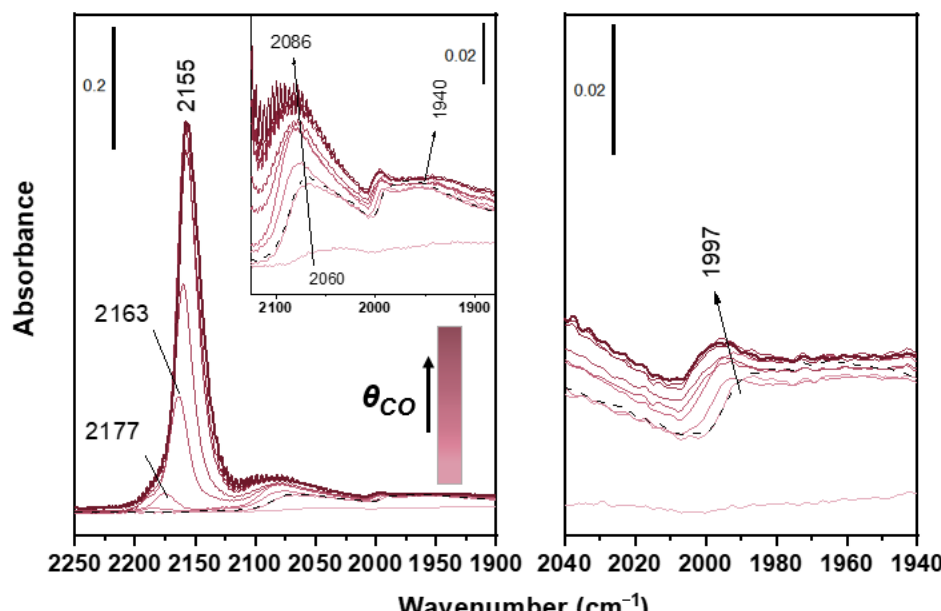
Figure 2. FT-IR spectra of CO adsorption at LNT on fresh sample after 400 °C-0.5 h oxidation-reduction (O 2 -H 2 ) pretreatment at increasing pressure of CO up to 20 mbar and after final outgassing at LNT (black dotted line).